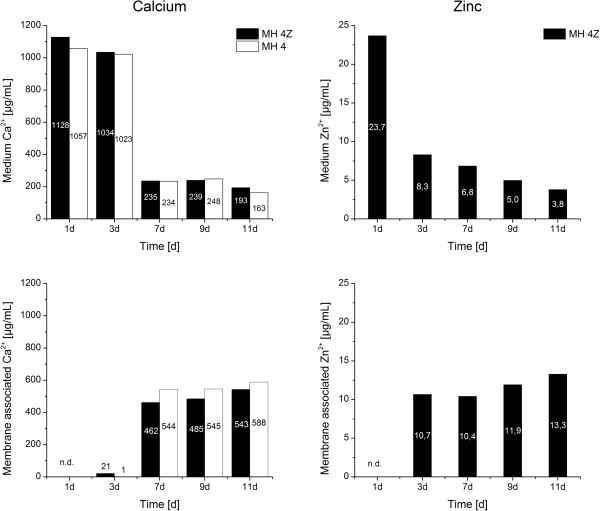
Calcium and zinc concentrations were determined in media and membrane associated by ICP-OES. Halomonas halophila were cultivated in MH 4 and MH 4Z medium. Samples at 1, 3, 7, 9, and 11 days were analyzed. Black columns: MH 4Z medium, white columns: MH 4 medium. Concentrations of calcium and zinc are indicated in the columns in μg/mL. The concentration of membrane associated calcium at day 1 was not determined (n.d.) due to cell density limitations.